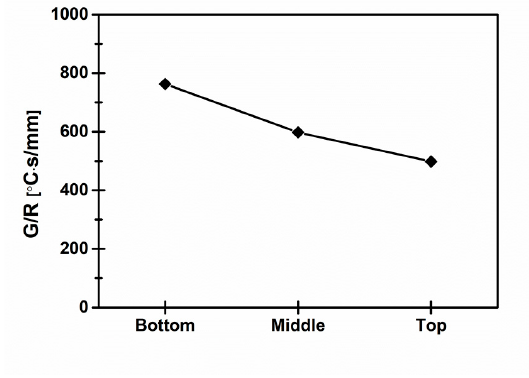
Figure 7. Behavior of G / R at each position in deposit .